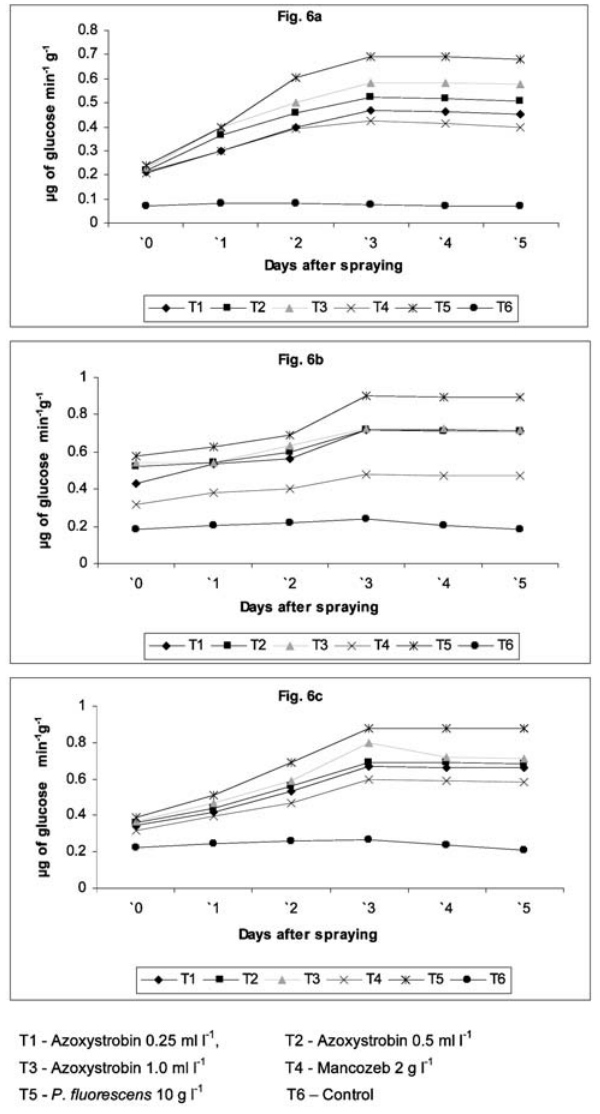
Fig. 6. Changes in beta- 1, 3-glucanase activity in cucum- ber plants: 6a, uninoculated and treated with azoxystrobin and Pseudomonas fl uorescens; 6b, challenge-inoculation of downy mildew pathogen; 6c, challenge-inoculation of powdery mildew pathogen.